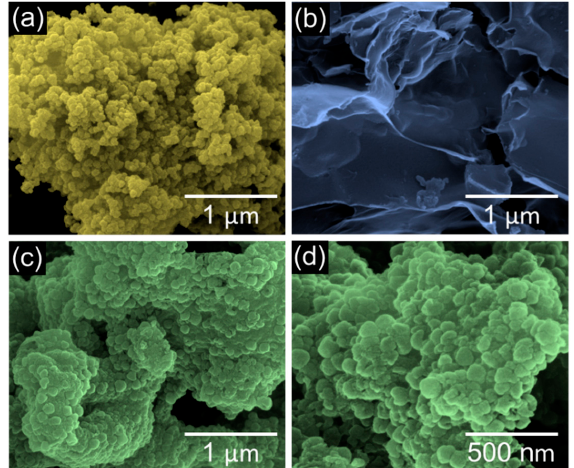
Figure 2. Scanning electron microscope (SEM) images of ( a ) silicon nanocrystals (nc-Si), ( b ) activated carbon (AC), ( c ) AC<nc-Si>AC nanocomposites, and ( d ) magnified SEM image of the AC<nc-Si>AC